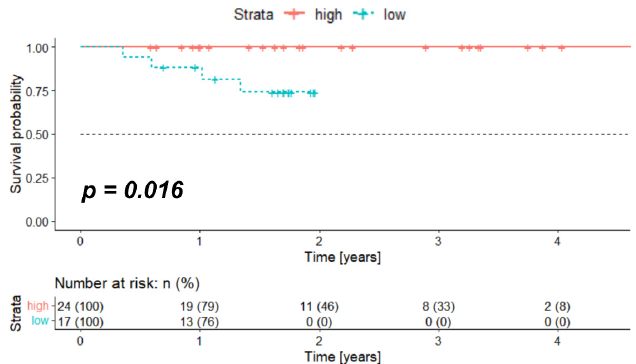
Figure 1. High Crebbp mRNA expression is associated with better survival in HPV-positive OPSCC patients. Kaplan–Meier survival curve for patients with HPV-positive OPSCC extracted from the TCGA database and stratified according to the OTV of Crebbp . HPV; human papillomavirus, OPSCC; oropharyngeal squamous cell carcinoma, TCGA; The Cancer Genome Atlas, Crebbp ; CREB-binding protein, OTV; optimized threshold value.